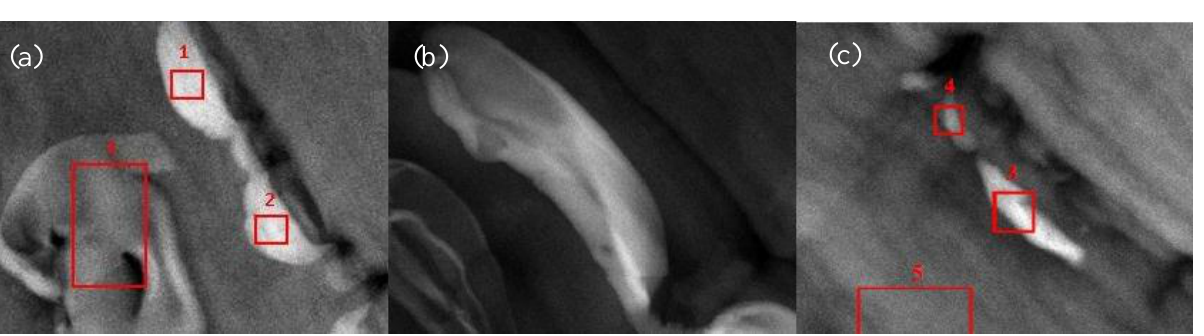
Figure 10. STEM images for ( a ) PP-acetic; ( b ) PP-formic and ( c ) PP-Base samples. Brighter locations show the presence of silicon